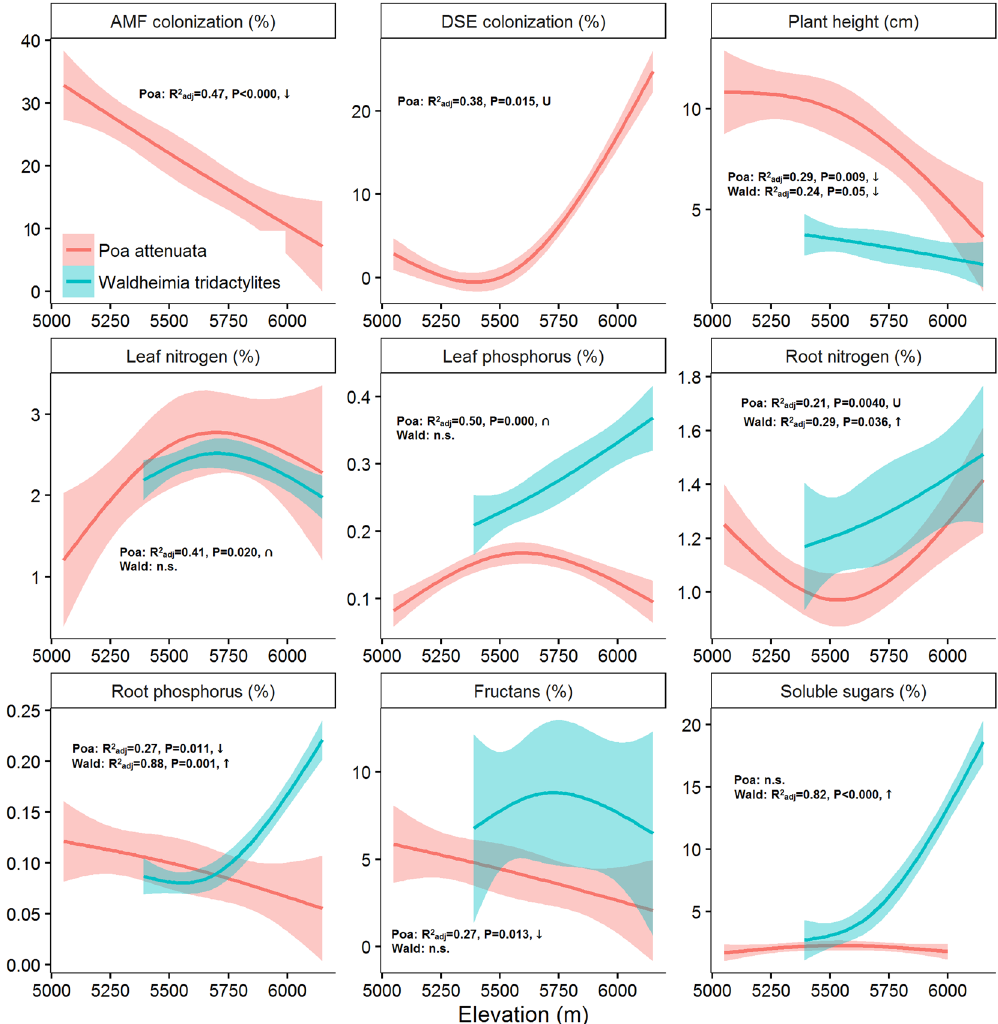
Figure 7. Variation in trait values for Poa attenuata and Waldheimia tridactylites on elevational gradient. The influence of elevation was analyzed using the RLM (Robust Fitting of Linear Models, thick lines) and is shown with 95% confidence